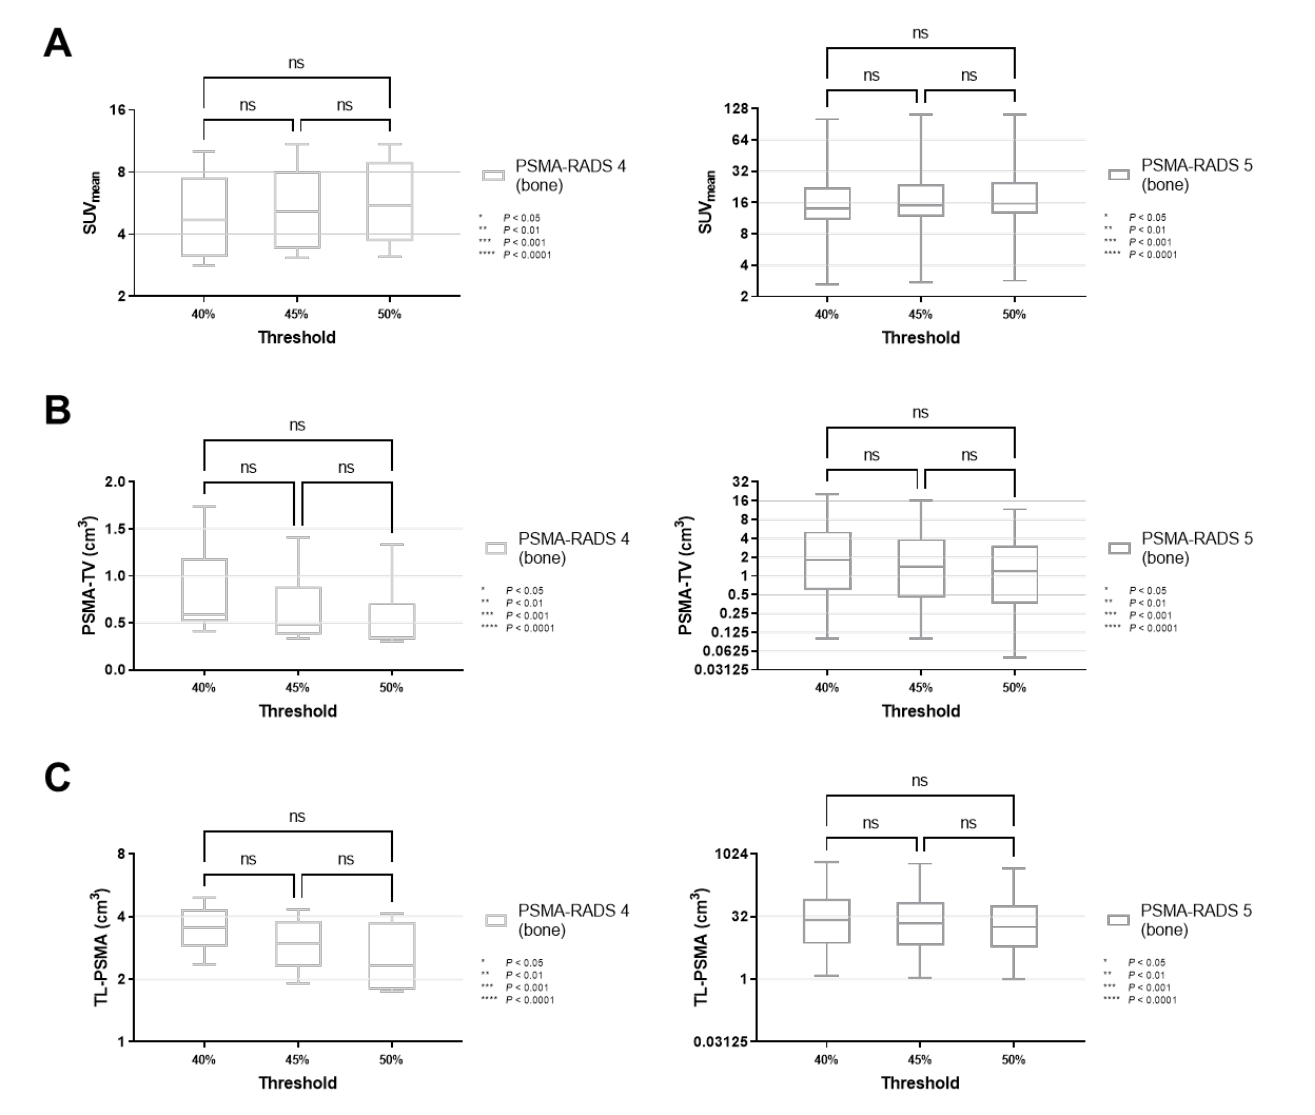
Figure 5. Box-and-whisker charts showing the mean standardized uptake values (SUV mean , ( A )) and volumetric parameters [PSMA-avid tumor volume (PSMA-TV, ( B )), and total lesion (TL-PSMA, ( C ))], depending on the chosen intensity threshold (40 vs. 45 vs. 50%), for bone lesions classified as PSMA-RADS-4 or -5. SUV mean ( p ≥ 0.31), PSMA-TV ( p ≥ 0.11) and TL-PSMA ( p ≥ 0.33) did not differ significantly when changing the intensity threshold. Data are shown on a logarithmic scale (exception: linear scale for PSMA-TV in the PSMA-RADS-4 cohort). PSMA-RADS = prostate-specific membrane antigen reporting and data system.